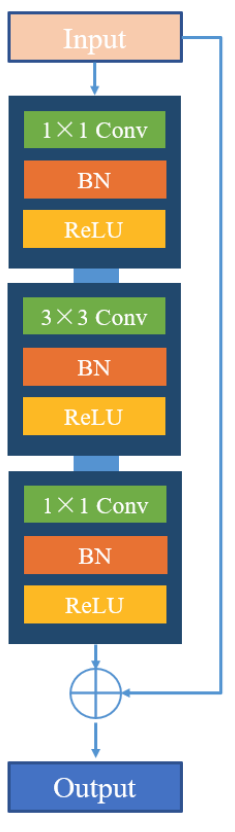
Figure 4. The structure of residual block.